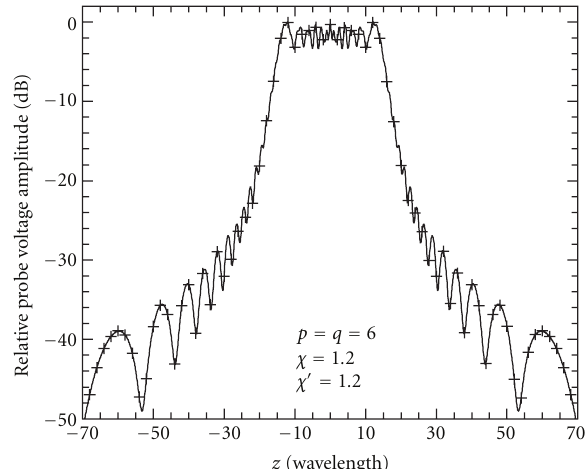
Figure 3: Amplitude of the probe voltage V on the generatrix at ϕ = 90 ◦ . Solid line: exact. Crosses: recovered from irregularly spaced NF data at the iteration 8.